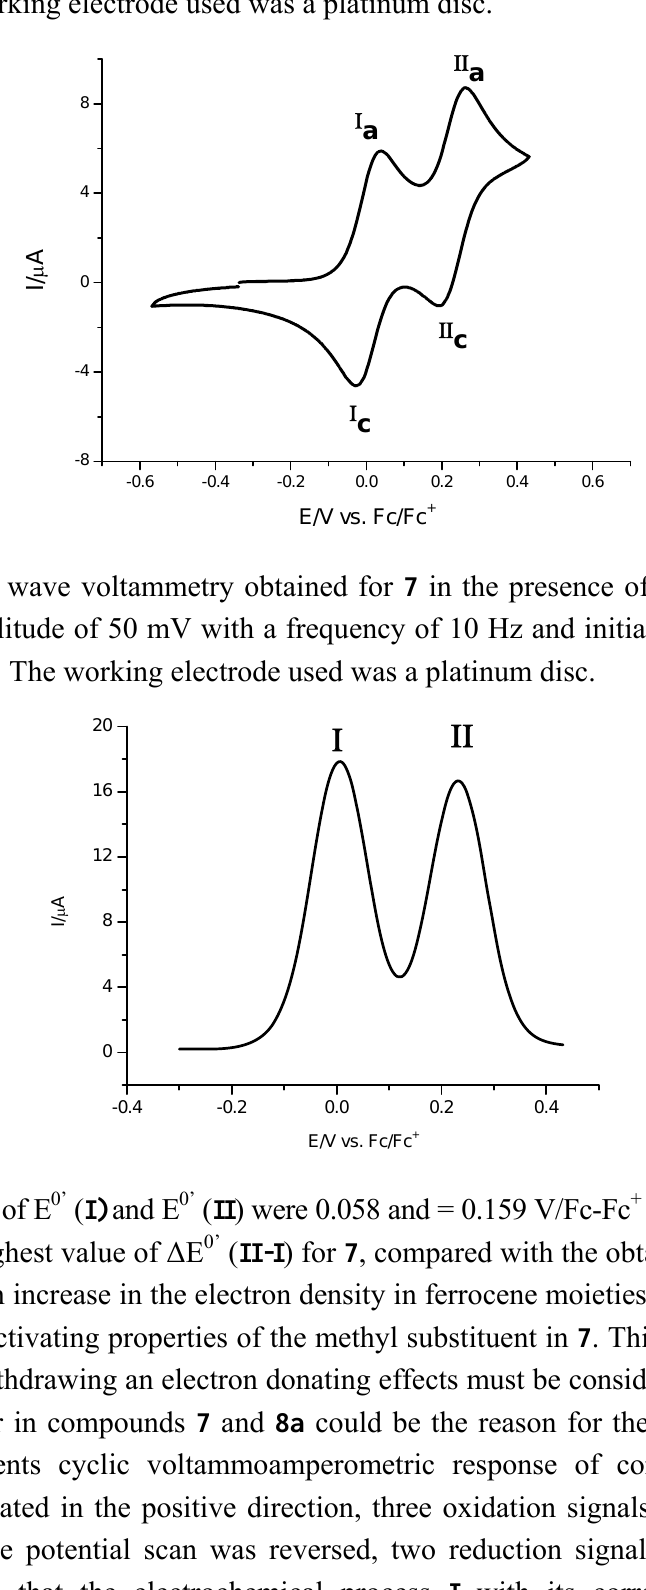
in 4 in the positive ocp